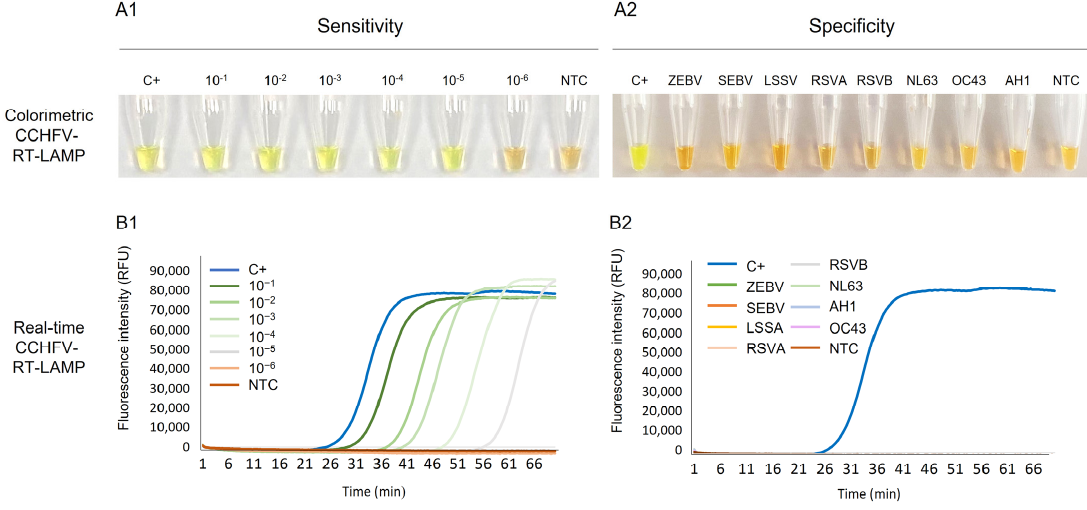
Figure 2. Establishing the RT-LAMP assay: sensitivity and specificity assessments for CCHFV RNA detection. ( A1 ) Colorimetric RT-LAMP verification and sensitivity assessment. Lane C+, RNA-positive control (5 ng/ µ L); Lanes 10 − 1 to 10 − 6 : 10-fold dilutions of CCHFV RNA sample used as positive control (C+); lane NTC, non-template control (ultra-pure water as template). ( A2 ) Specificity assessment of colorimetric RT-LAMP. Lane C+, RNA-positive control; lanes ZEBV, SEBV, LSSV, RSVA, RSVB, NL63, OC43 and AH1: RNA from haemorrhagic viruses (Zaire Ebola virus, Sudan Ebola virus, Lassa virus) and other respiratory viruses (respiratory syncytial virus A, respiratory syncytial virus B, coronavirus NL63, coronavirus OC43 and influenza A H1, respectively. Lane NTC, non-template control (ultra-pure water as template). ( B1 ). Real-time RT-LAMP verification and sensitivity assessment. Lane C+, RNA-positive control (5 ng/ µ L); Lanes 10 − 1 to 10 − 6 : 10-fold dilutions of CCHFV RNA sample used as positive control (C+); lane NTC, non-template control (ultra-pure water as template). ( B2 ) Specificity assessment of real-time RT-LAMP. Lane C+, RNA-positive control; lanes ZEBV, SEBV, LSSV, RSVA, RSVB, NL63, OC43 and AH1: RNA from haemorrhagic viruses (Zaire